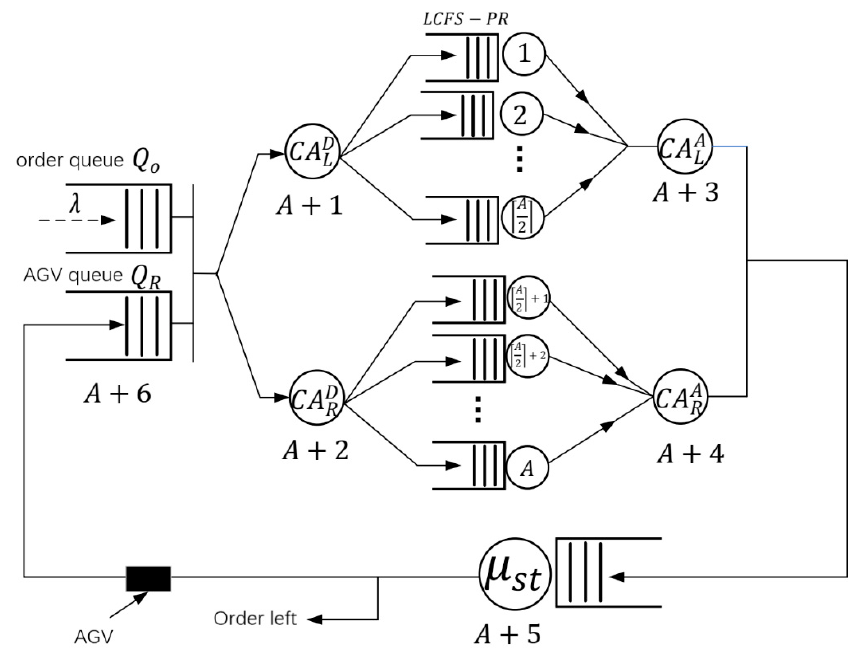
Figure 3. Queuing network model of the AGV